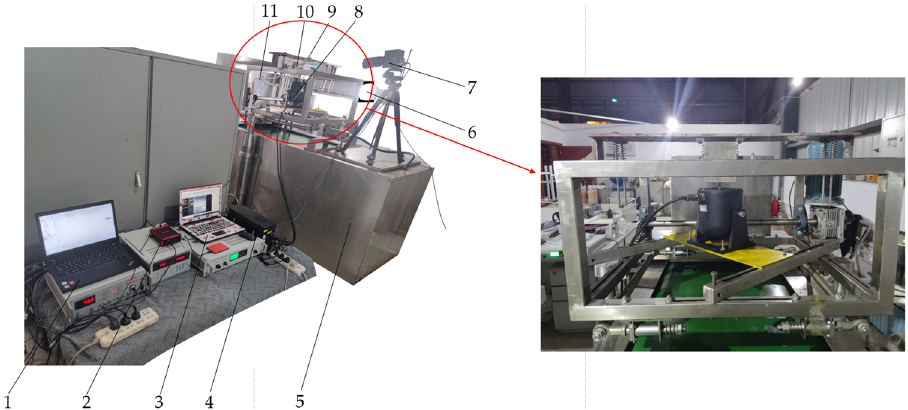
Figure 6. Vibration seed ‐ metering test bench: (1) computer for vibration measurement, (2) uT3604FS (16bit) data collector, (3) computer for high ‐ speed camera, (4) host of high ‐ speed camera, (5) JPS ‐ 12 seed ‐ meter performance test bench, (6) exposure lamp, (7) high ‐ speed camera, (8) seed-meter performance test bench, (6) exposure lamp, (7) high-speed camera, (8) DH40200 type DH40200 type vibration exciter, (9) CA ‐ YD ‐ 103 piezoelectric acceleration sensor, (10) vibration exciter, (9) CA-YD-103 piezoelectric acceleration sensor, (10) seed-metering device,